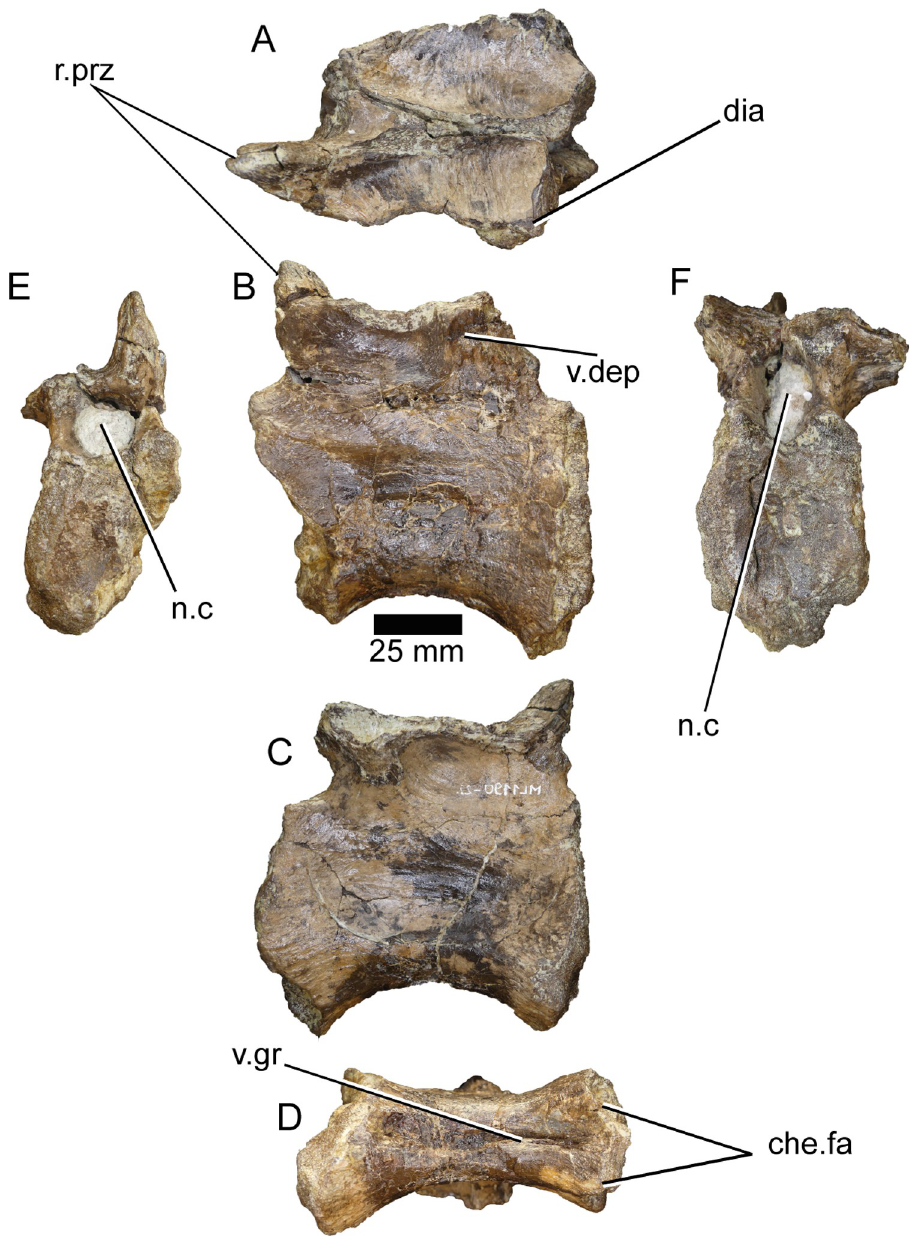
Fig 16. Caudal vertebra of Iberospinus natarioi (ML1190-22). A , Dorsal, B, C , lateral, D , ventral, E , anterior and F posterior view. che.fa , chevron facets, dia , diaphysis, n.c , neural canal, prz , remains of prezygapophysis, v.dep , ventral depression in the neural arch, v.gr , ventral